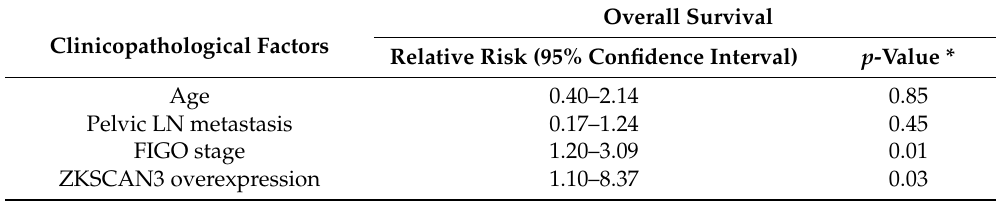
* Multivariate analysis by the Cox multiple regression model after backward stepwise elimination with variables eliminated at p < 0.1.